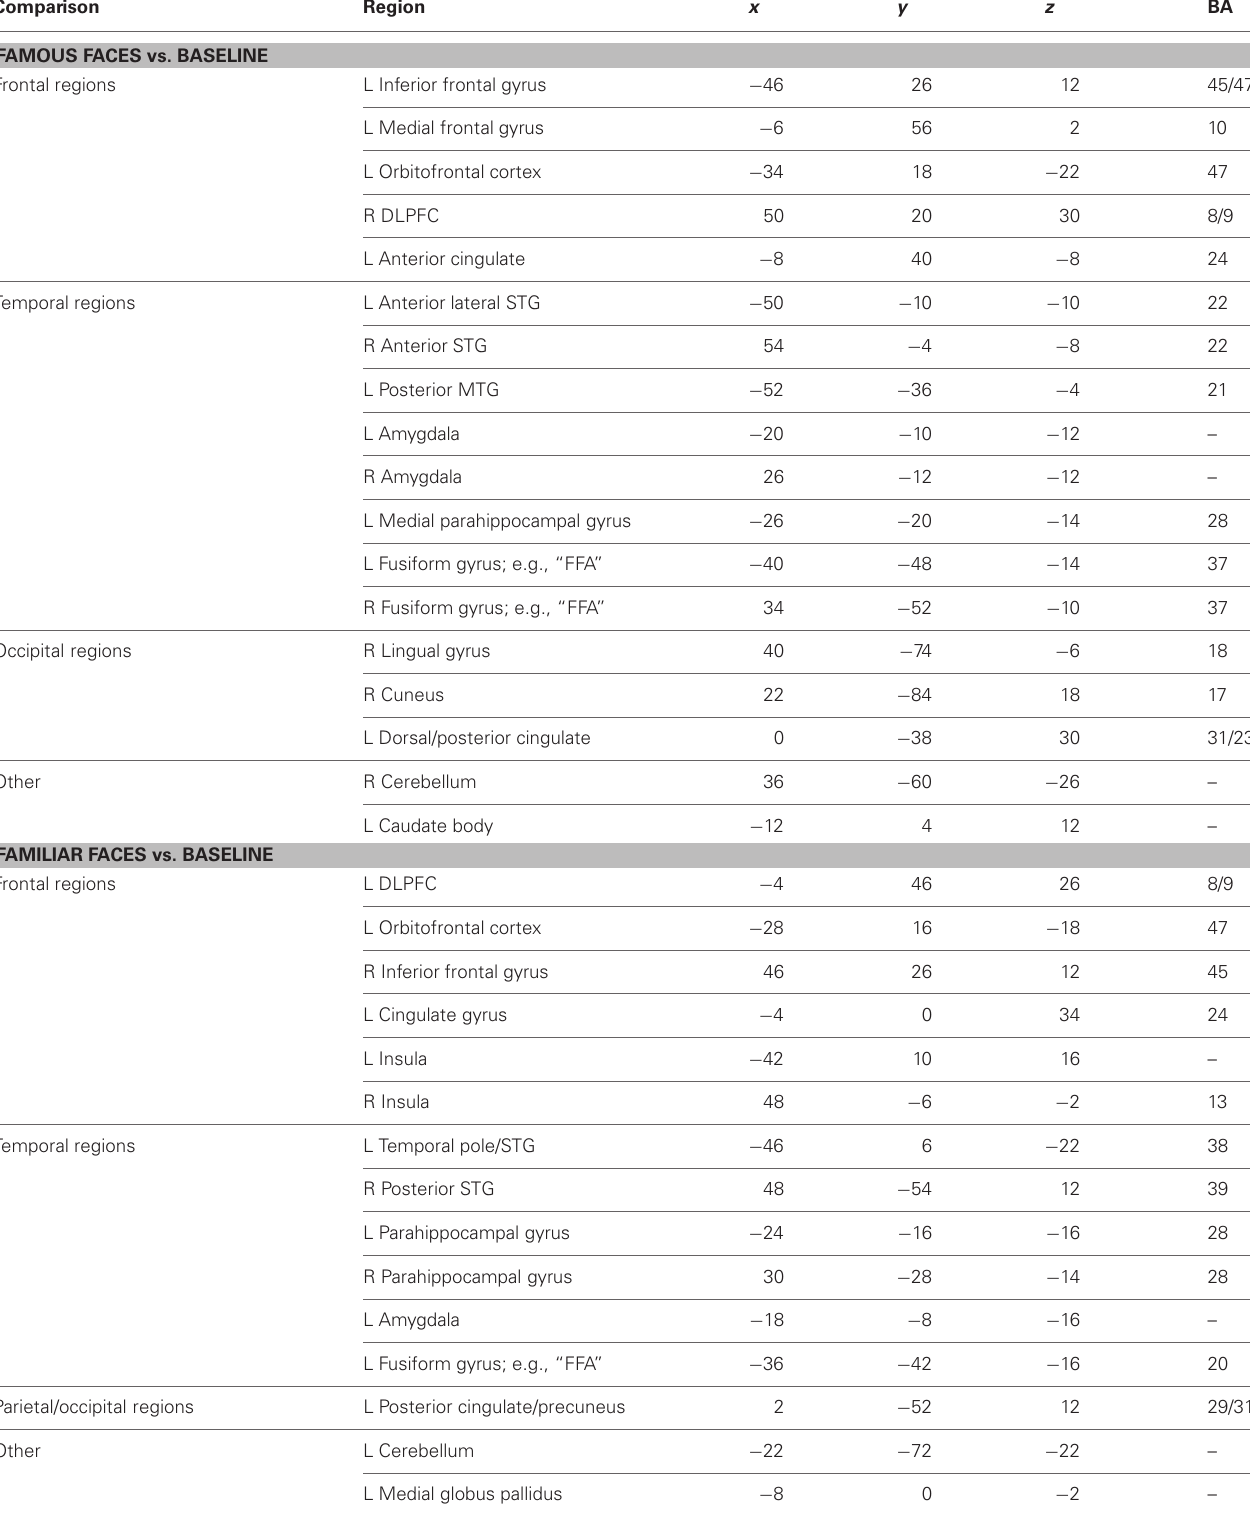
Table 2 | Talairach coordinates of peak activations from the random effects ALE meta-analysis. Comparison Region x y z BA FAMOUS FACES vs. BASELINE